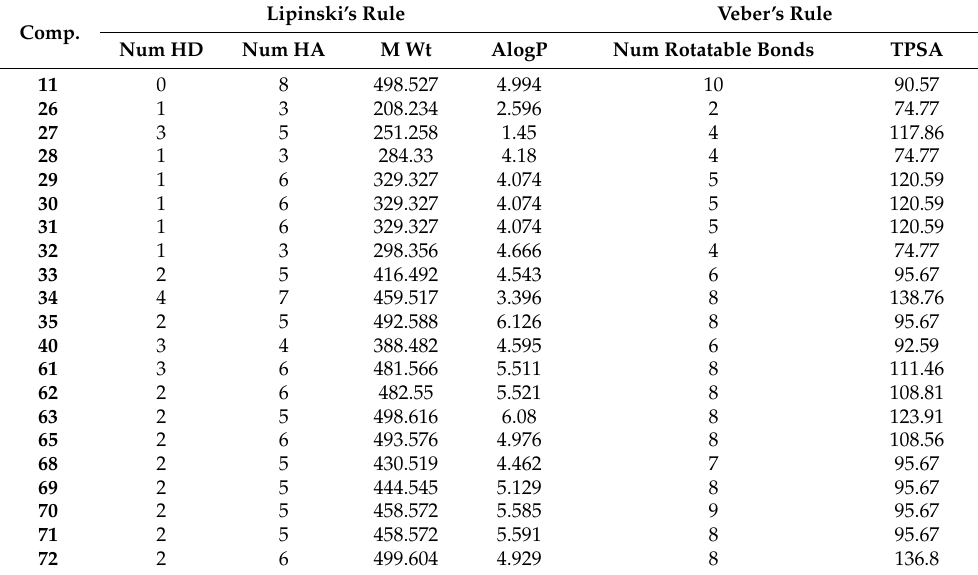
Table 1. Physicochemical properties of the tested compounds passed Lipinski’s and Veber’s Rules.